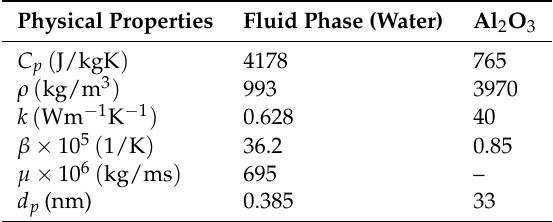
Table 2. Thermo-physical properties of water with Al 2 O 3 nanoparticles at T = 310 K [19,38]. Physical Properties Fluid Phase